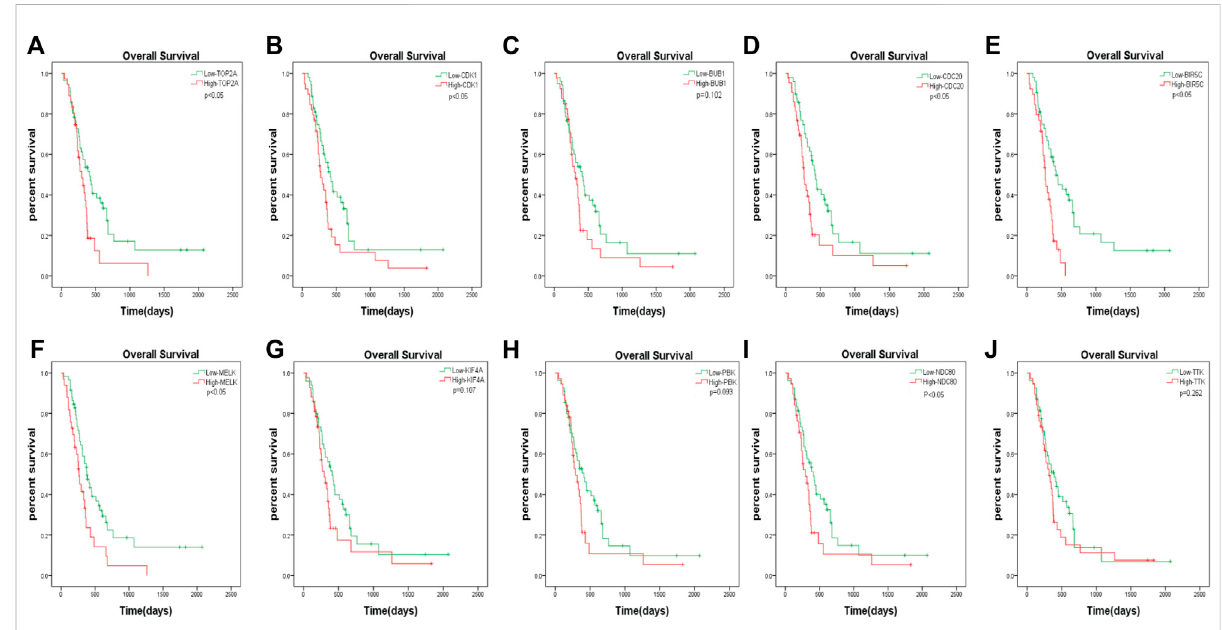
FIGURE 7 The prognostic values of hub genes in GBM. High mRNA level of any one gene of TOP2A , CDK1 , CDC20 , BIRC5 , MELK , and NDC80 was associated with overall survival (OS) in all GBM patients p < 0.05. Four hub genes ( BUB1 , KIF4A , PBK and TTK ) had no statistical signi fi cance between gene expression and the clinical outcome of GBM.